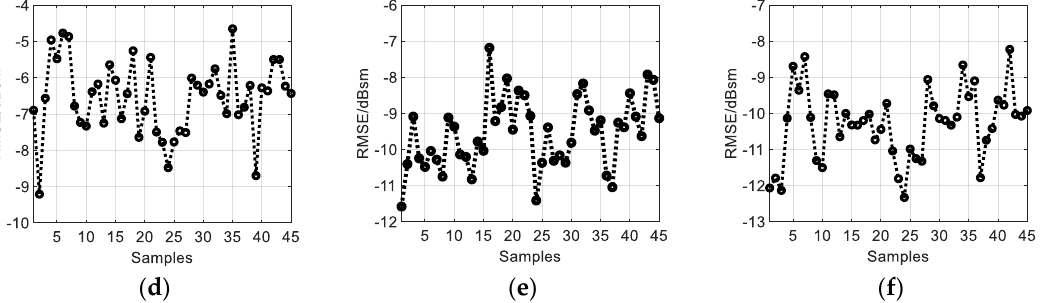
Figure 6. The training and testing result of three different datasets ( a ) training error for 3 × 66 samples ( b ) training error for 3 × 122 samples ( c ) training error for 3 × 244 samples ( d ) testing RMSE for 3 × 66 samples ( e ) testing RMSE for 3 × 122 samples ( f ) testing RMSE for 3 × 244 samples.